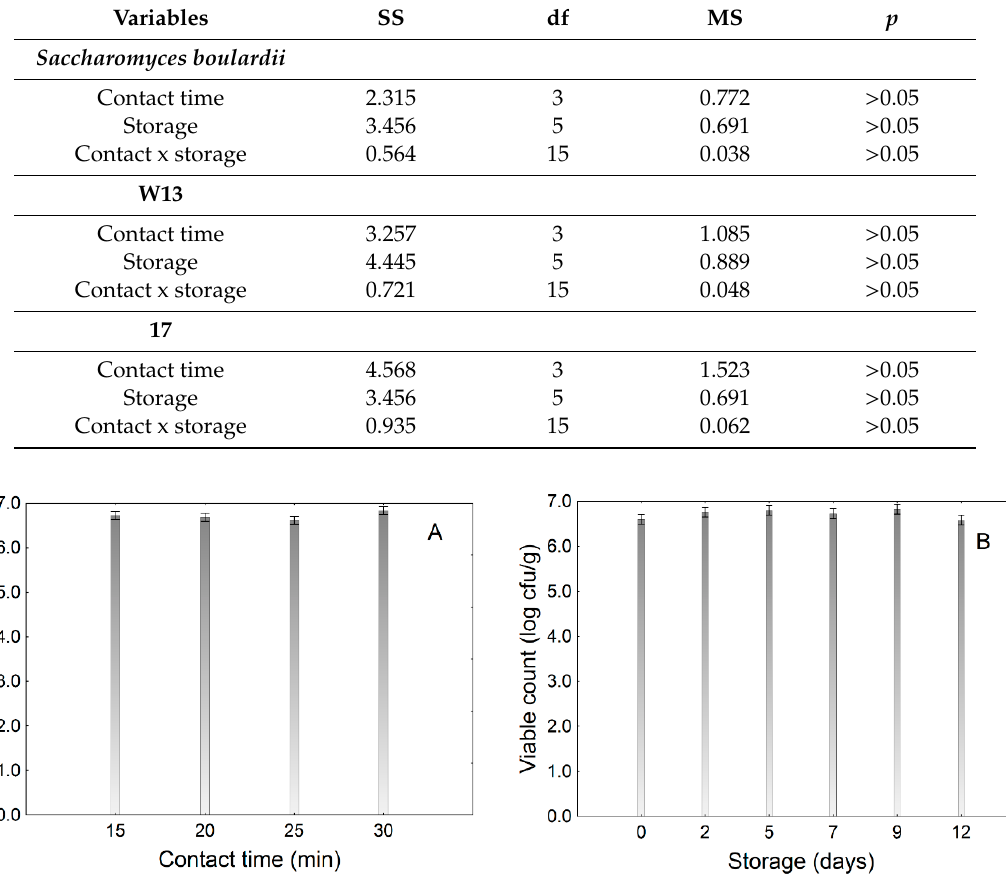
Figure 1. Decomposition of the statistical hypothesis for the effects of the contact time of the yeast solution/apple piece ( A ) and storage at 4 °C ( B ) on the viability of S. boulardii . Bars denote 95% confidence intervals. The differences were not significant (two-way ANOVA, p > 0.05). Table 1. Statistical effects of the contact time of apple pieces in the mother solution (contact) and the duration of the storage at 4 °C on the viability of yeasts. One-way ANOVA and Tukey’s test ( p < 0.05). SS, sum of squares; df, degrees of freedom; MS, mean sum of squares.